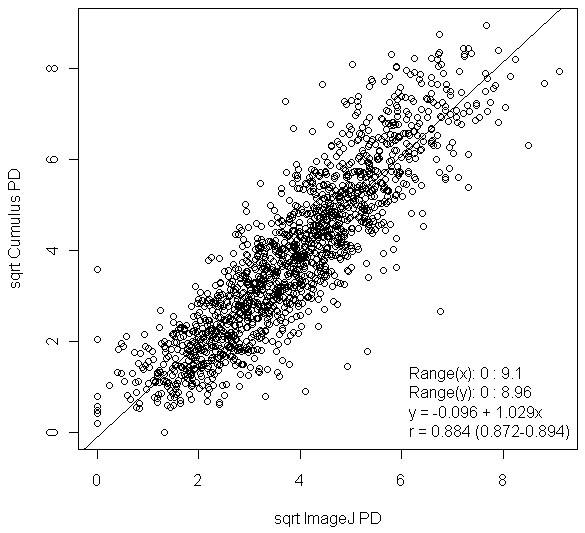
Scatterplot of Cumulus PD and ImageJ PD. Sqrt, square-root transformed; r, Pearson product-moment correlation coefficient; x, x-axis; y, y-axis.